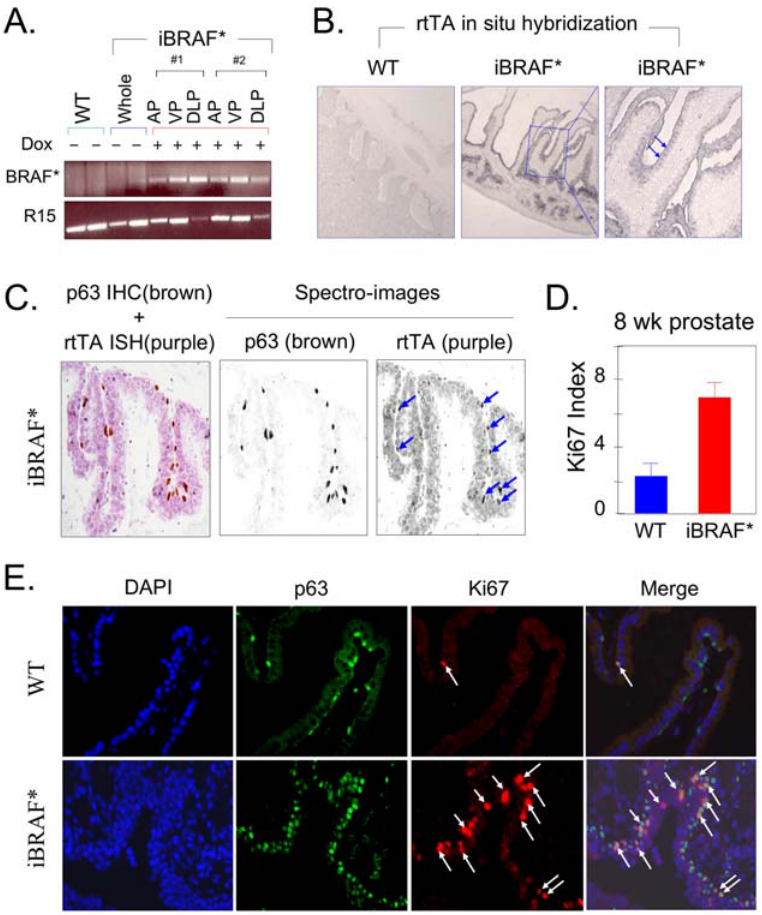
Figure 1. Transgene BRAF * expression in prostate epithelium drives aberrant proliferation of the p63 + prostatic basal cells. A. Transgene BRAF* transcript was detected in all three lobes (AP, anterior prostate; VP, ventral prostate; DLP, dorsolateral prostate) of the prostate glands from two independent 8-week-old bi-transgenic iBRAF* male mice on doxycycline by transgene-specific RT-PCR. As controls, whole prostate glands were isolated from WT or iBRAF* off doxycycline mice (n=2 for each). Ribosomal protein R15 was used as an internal control for RT-PCR. B. RNA in situ hybridization (RISH) using rtTA riboprobe documented expression of BRAF* transgene in prostate epithelial gland (200 6 ). Arrows indicate the expression of rtTA in luminal cell compartment in zoom-in with higher magnification (400 6 ). C. Expression of BRAF* transgene was detected in both luminal cells and p63 + basal cells of the prostate epithelium of 8-week-old bi-transgenic iBRAF* male mice on doxycycline using dual serial staining of p63 IHC and rtTA RISH. After quick incubation of slides with antibody against p63 for 10 minutes with IHC procedure, RISH procedure with rtTA RNA probe was followed. Brown color for p63 + basal cells by IHC and purple color for rtTA expression by RISH were differentially detected by spectro-imaging machine. Note the co-localization of strong rtTA expression and p63 immuno-reactivity in approximately 50% of p63 + basal cells (arrows). D. Ki67 staining of histologically-normal prostate glands in 8-week-old males showed increased proliferation index in iBRAF* transgenic (on doxycycline) compared to WT. E. Co-immunofluorescence study in prostate glands isolated from 8-week-old WT and iBRAF* transgenic (on doxycycline) males showed the expansion of p63 + basal cells in the prostate glands of iBRAF* mice. Approximately half of the p63 + cells were in proliferation as measured by co-staining with Ki67 (see